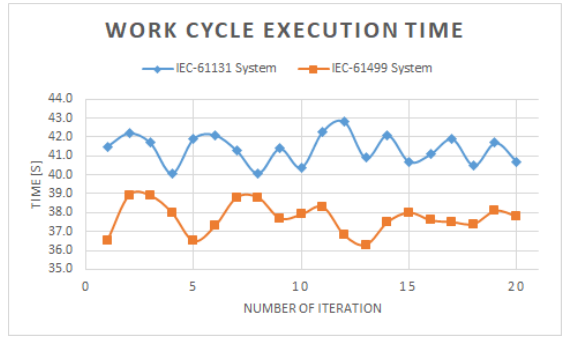
Figure 15. Work cycle execution time test